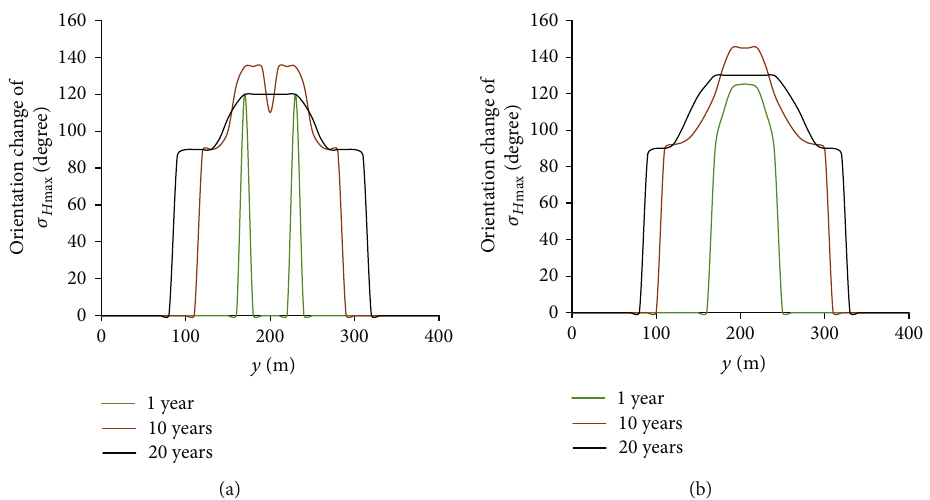
Figure 20: (a) and (b) present the change in reorientation of σ fractures and under di ff erent depletion years,